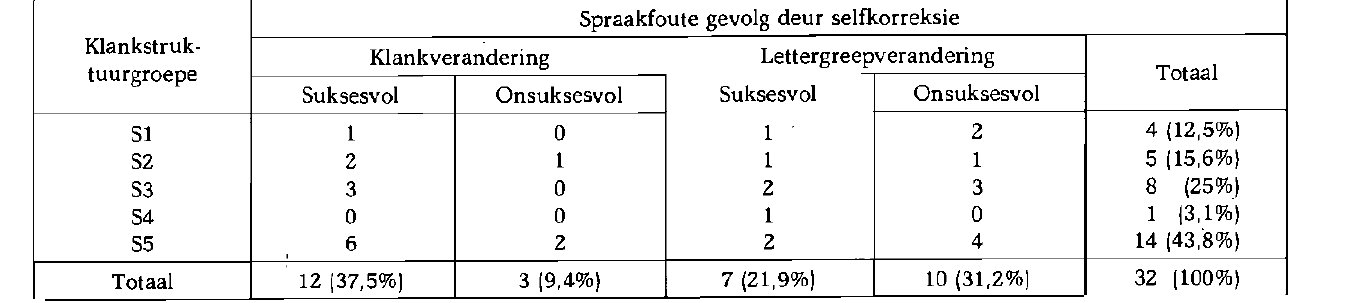
Tabel 6: Spraakfoute gevolg deur selfkorreksie by die verskillende